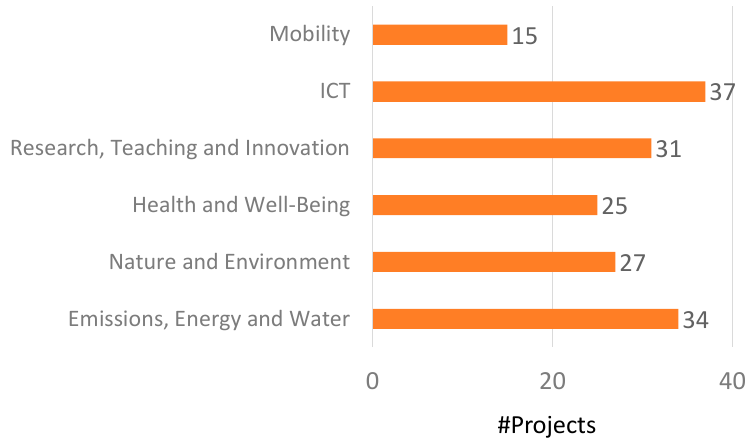
Figure 14. Number of projects in relation to the UMA Smart-Campus pillars.